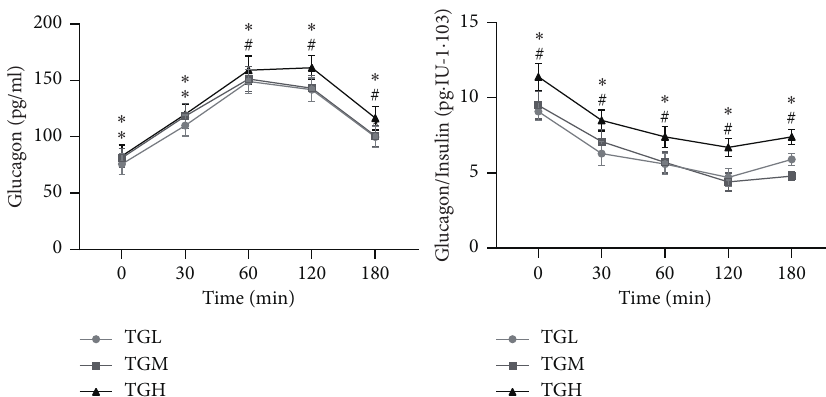
Figure 1: Glucagon and glucagon/insulin before and after OGTT among patients with different HbA1c. TGL: TG < 1.7mmol/L; TGM: TGM 1.7 ≤ TG < 2.3mmol/L; and TGH: TG ≥ 2.3mmol/L. ∗ P < 0 . 05 versus TCL; # P < 0 . 05 versus